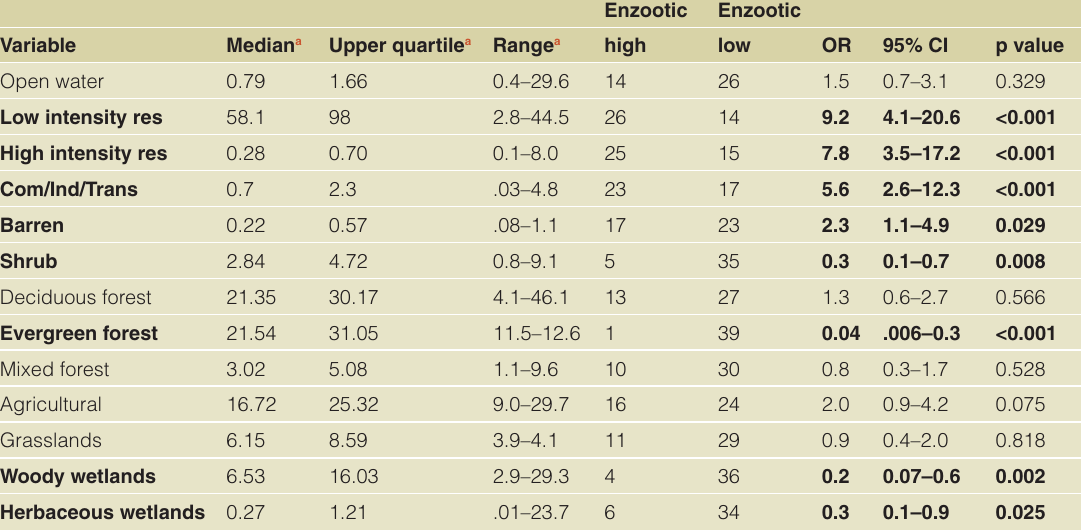
Table 2. Crude odds ratios for land-use patterns associated with relative risk of high enzootic raccoon rabies ( ≥ 8 positive cases) within 159 Georgia